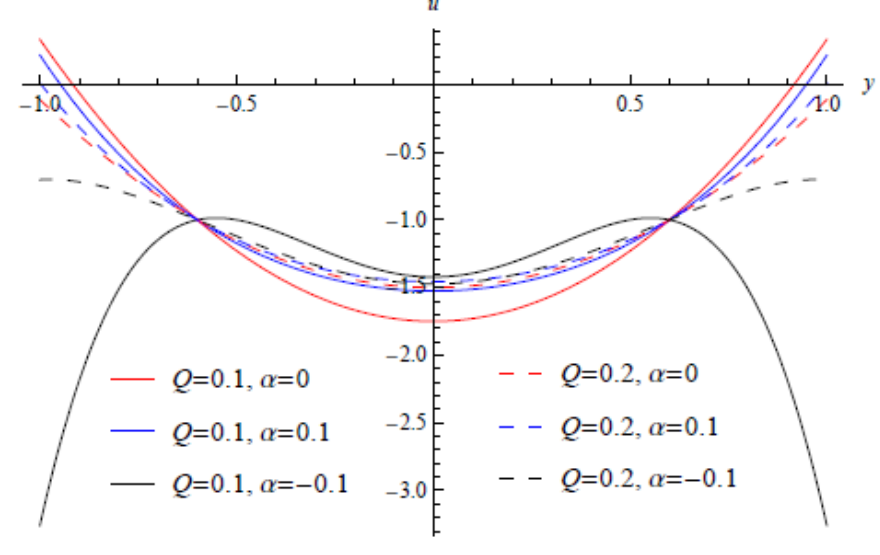
Fig. 7 (a). Velocity profile for different value of